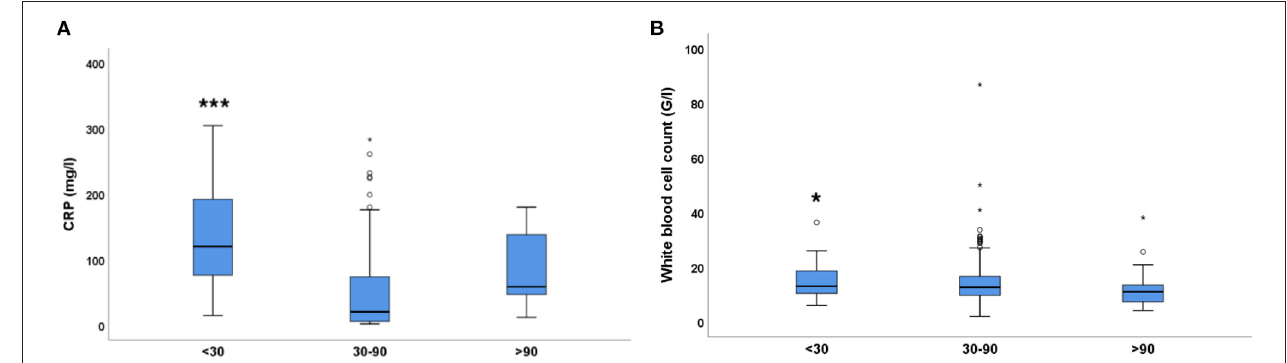
FIGURE 4 | Inflammatory parameters (CRP, WBC count) in the 3 eGFR groups. (A) C-reactive protein (CRP, mg/L), One-way ANOVA with Tukey’s post-hoc test; *** p < 0.001. (B) White blood cell count (10 9 /L), Independent samples Kruskal Wallis test; * p = 0.05 ( < 30 vs. > 90). Small circles and stars represent outlier data.